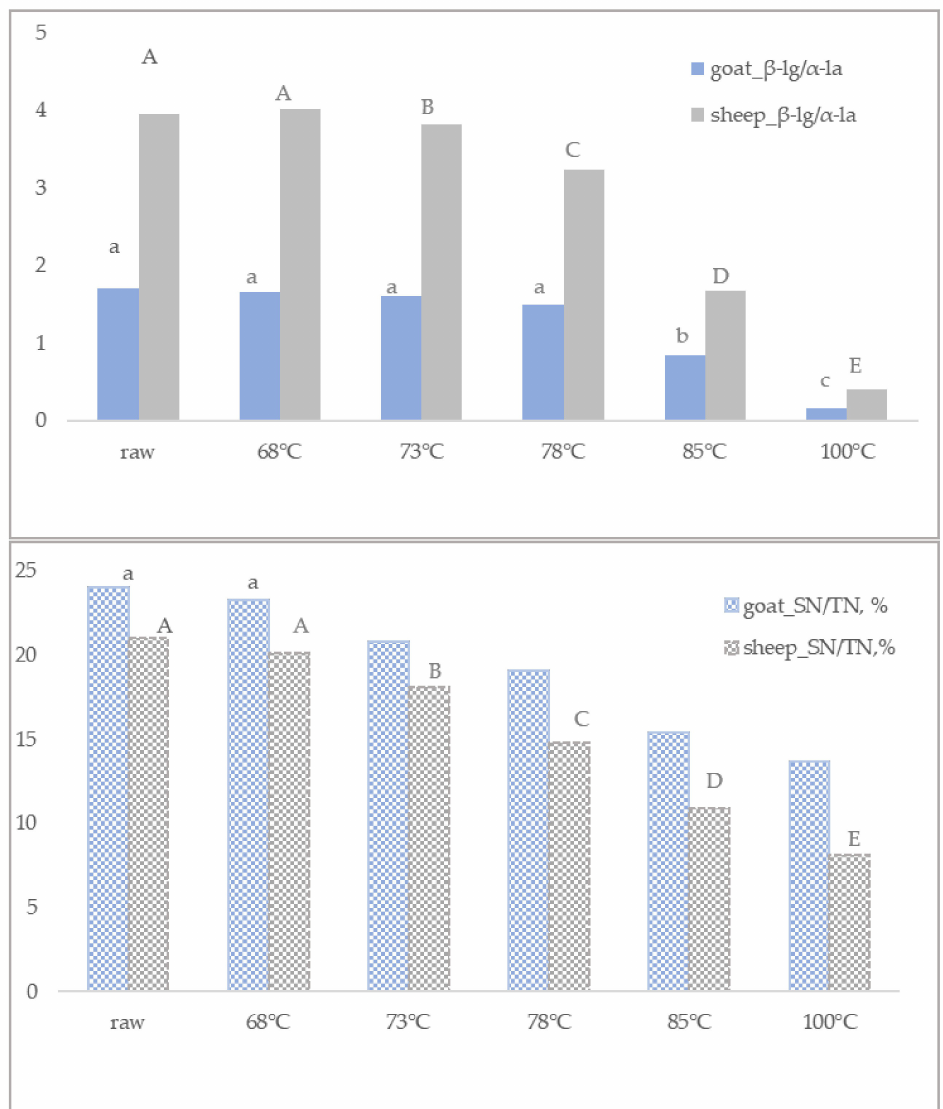
Figure 1. Effect of continuous flow-through treatments at different temperatures for 16 s on the β -lg/ α -la and SN/TN ratios of goat and sheep milk. Different letters indicate statistically significant differences ( p < 0.05) between the treatments of each milk